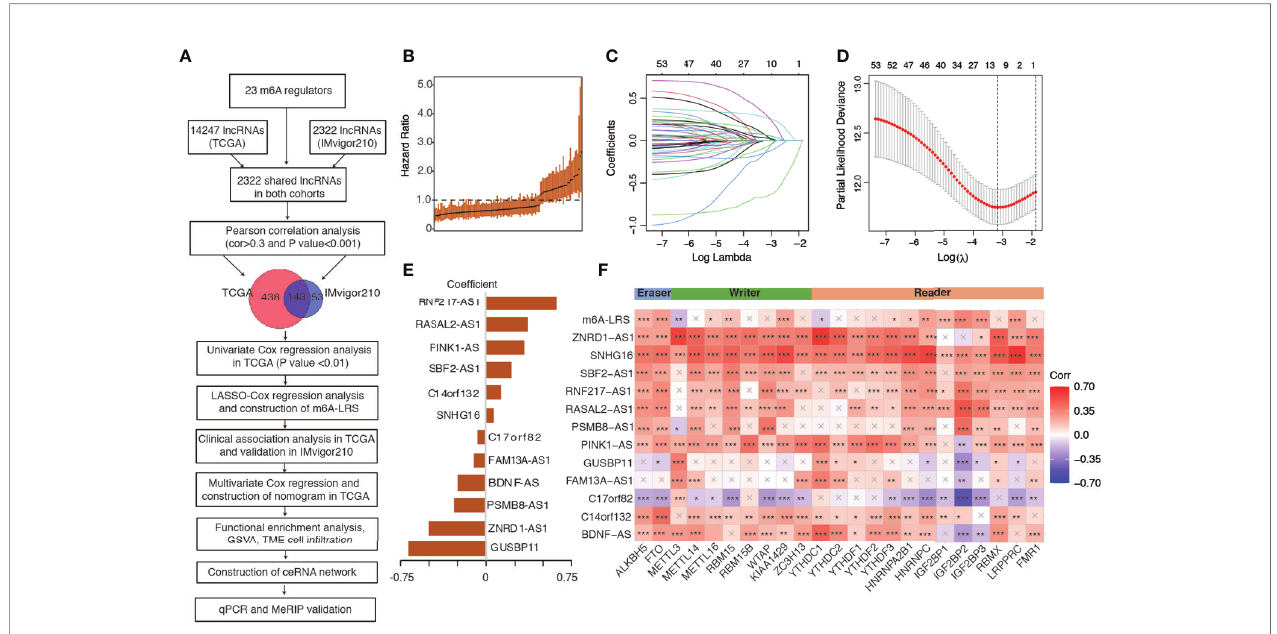
FIGURE 1 | Study fl owchart and construction of the m6A-related lncRNA risk score. (A) Study fl owchart. (B) The hazard ratio of the 143 m6A-related lncRNAs for overall survival in the TCGA cohort. Error bars indicate 95% con fi dence intervals. (C, D) Least absolute shrinkage and selection operator (LASSO) regression model. (E) Coef fi cients of the LASSO-Cox model with the minimum lambda criteria. (F) Heatmap of the correlations between m6A regulators, 12 prognostic m6A-related lncRNAs, and the corresponding risk score. An “ X ” indicates a non-signi fi cant correlation (P > 0.05), *P < 0.05, **P < 0.01, ***P < 0.001. m6A-LRS: m6A-related lncRNA risk